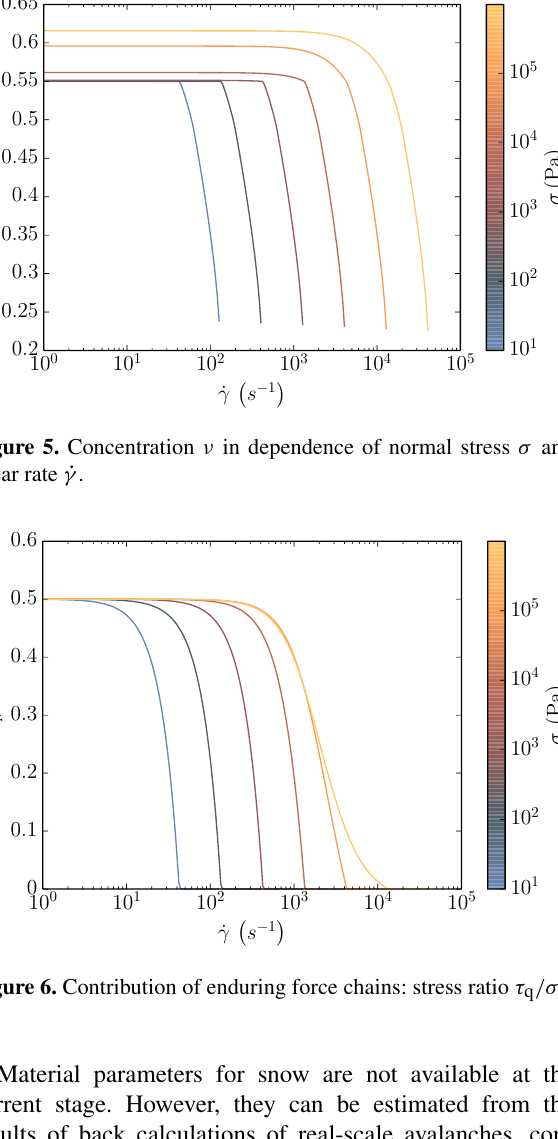
Material parameters for snow are not available at the current stage. However, they can be estimated from the results of back calculations of real-scale avalanches, con- ducted in the second part of this paper. To qualitatively highlight the most important features of the constitutive model, it is analyzed for an idealized 1 mm quartz sand ( d